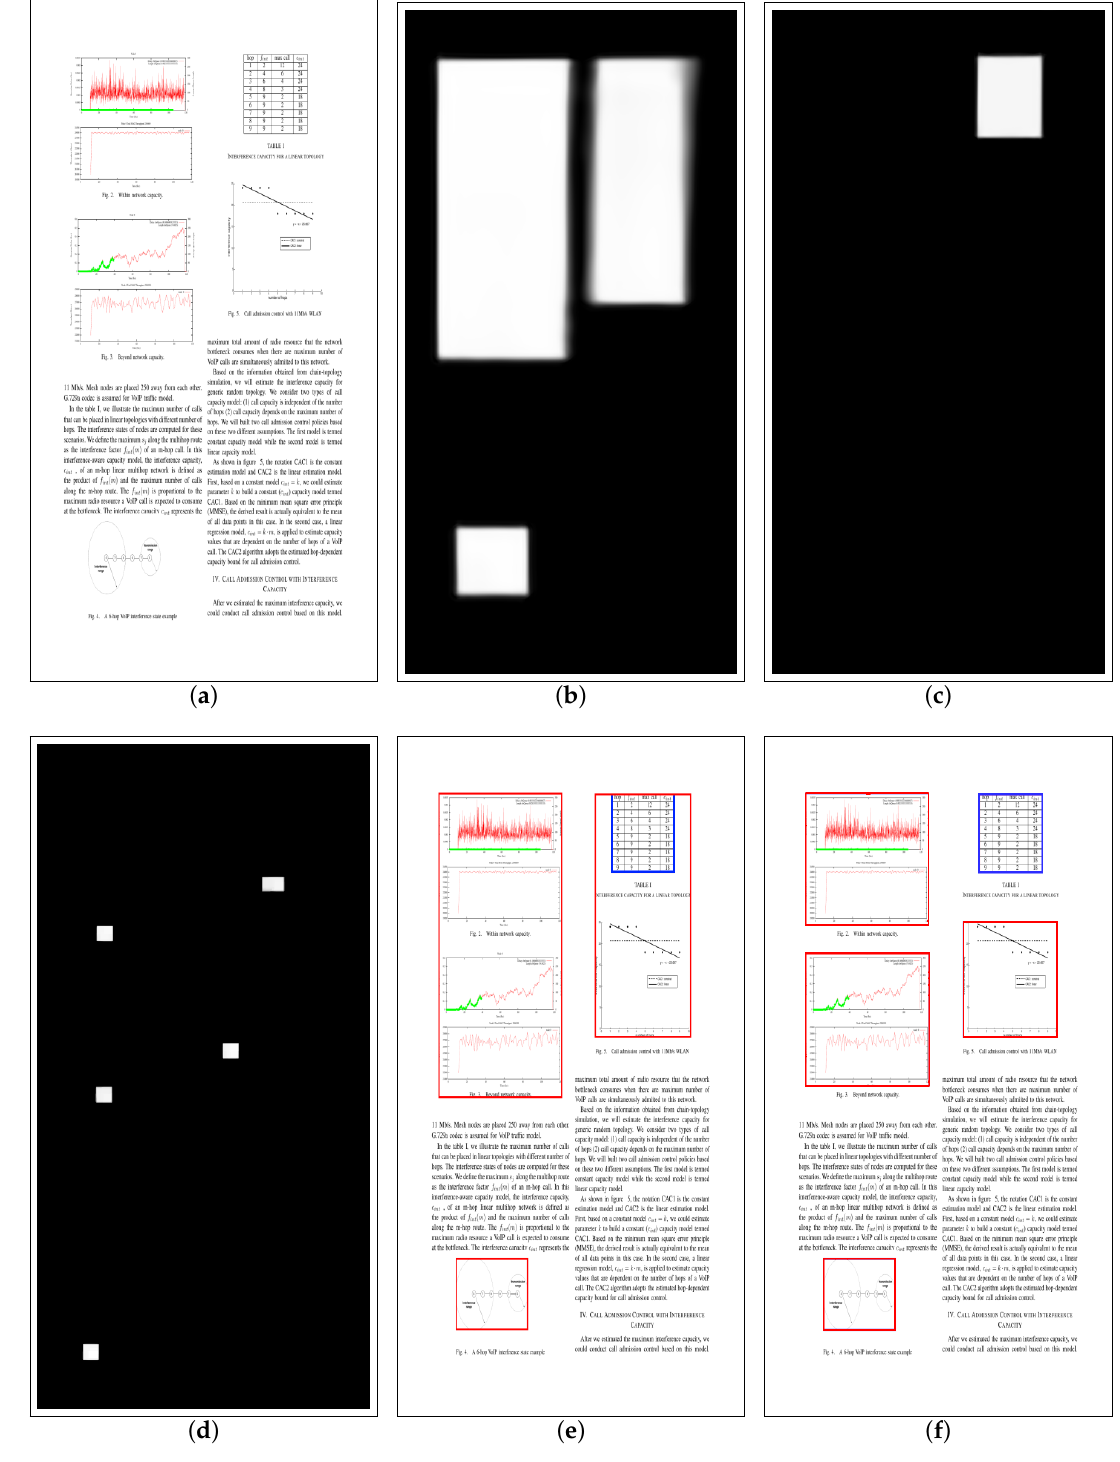
Figure 3. Intermediate outputs of the segmentation-based approach. In this case, the top right table was initially detected also as a figure and the networks did not detect the boundaries between some figures. However, with the knowledge of the tag positions, correct bounding boxes could nevertheless be detected. ( a ) original document; ( b ) heatmap figures; ( c ) heatmap tables; ( d ) heatmap tags; ( e ) initial boxes; ( f ) boxes